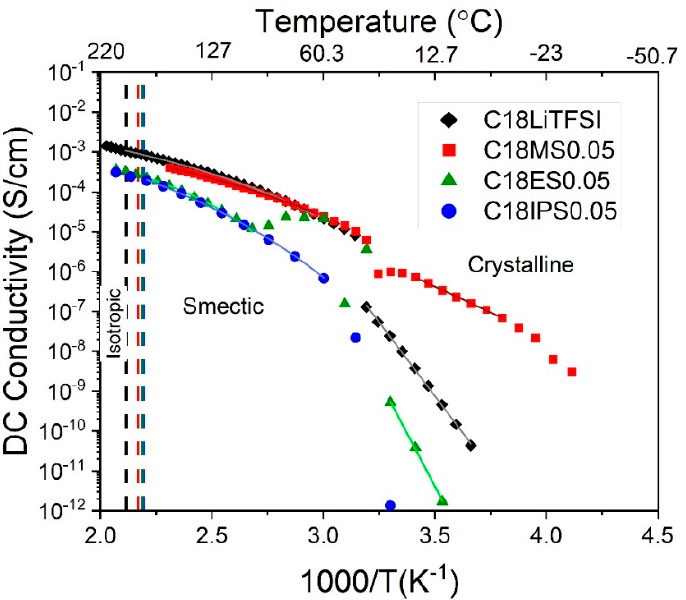
Figure 6. DC conductivity of 0.05:1 C18RS:C18LiTFSI ratios across temperatures compared to C18LiTFSI. Isotropic to smectic transition values measured using DSC are indicated by vertical lines for each material, and regressions calculated based on Arrhenius or VTF models are displayed as fit lines. Data for C18LiTFSI were originally reported in [21].